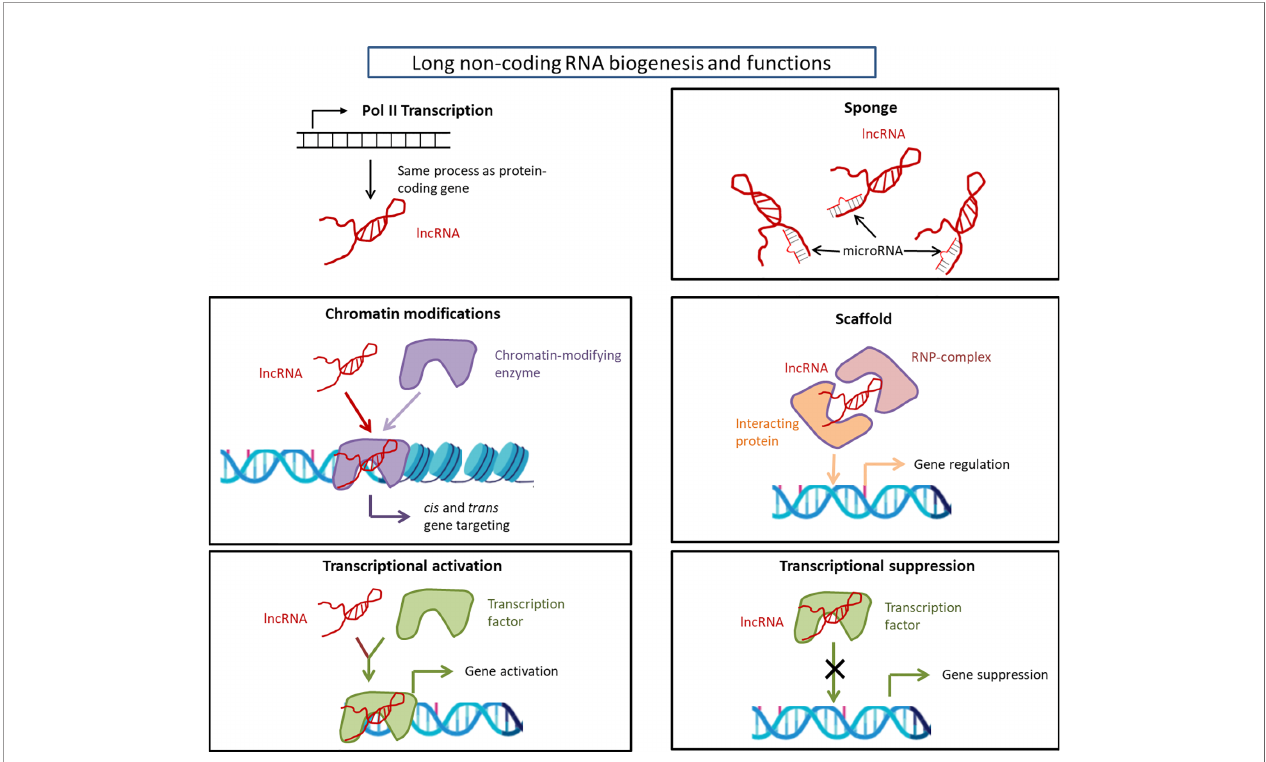
FIGURE 1 | Long non-coding RNA biogenesis and functions. Long non-coding RNAs are transcribed by RNA polymerase II and are processed to mature RNA by the same method as protein-coding mRNAs as detailed in the text. The considerable functions of lncRNAs are: chromatin modi fi cation, transcriptional activation/ suppression, sponge, and scaffold. The functions of lncRNAs depend on the type of lncRNAs. lncRNA, long non-coding RNA; RNP,